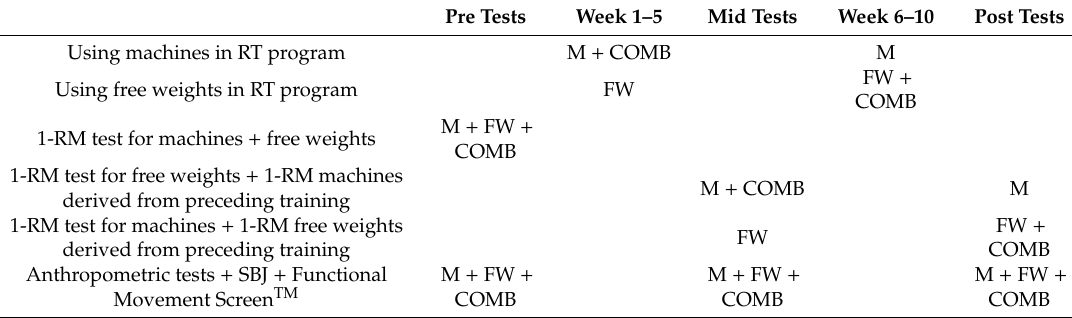
Table 2. Training and testing